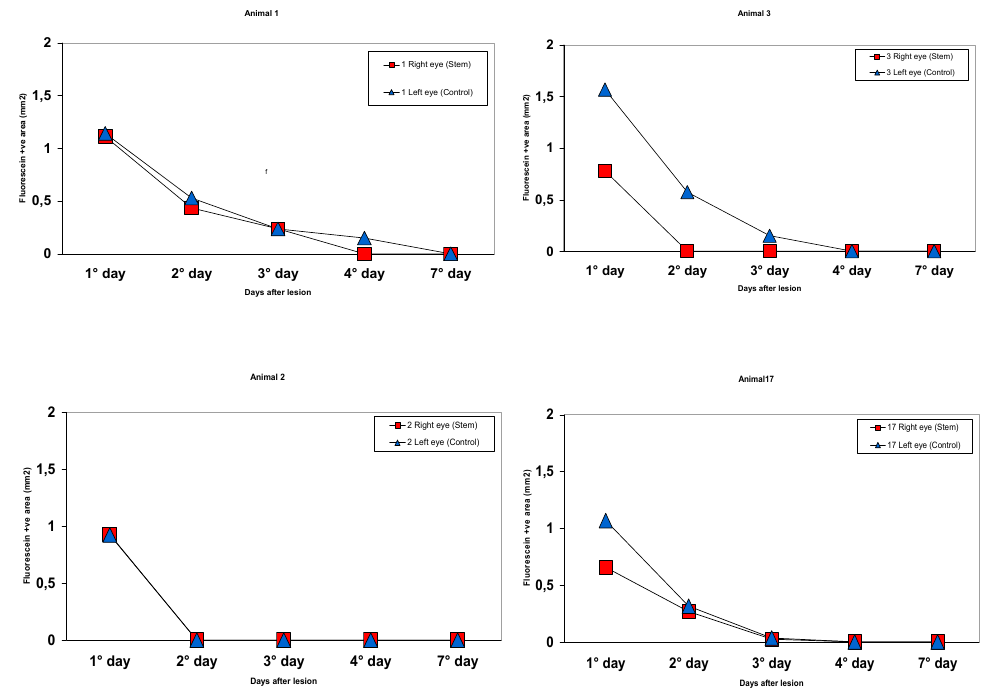
each time point for these eyes.